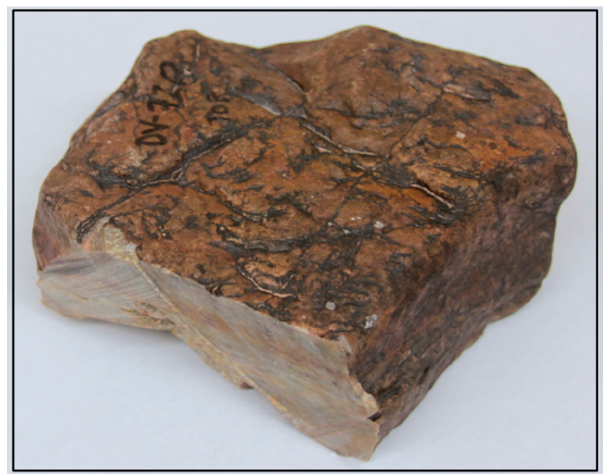
Figure 2. Sample JRK-DV-72, a strongly varnished clast of quartzite from Death Valley, California (36.38513 N, 118.84396 W).